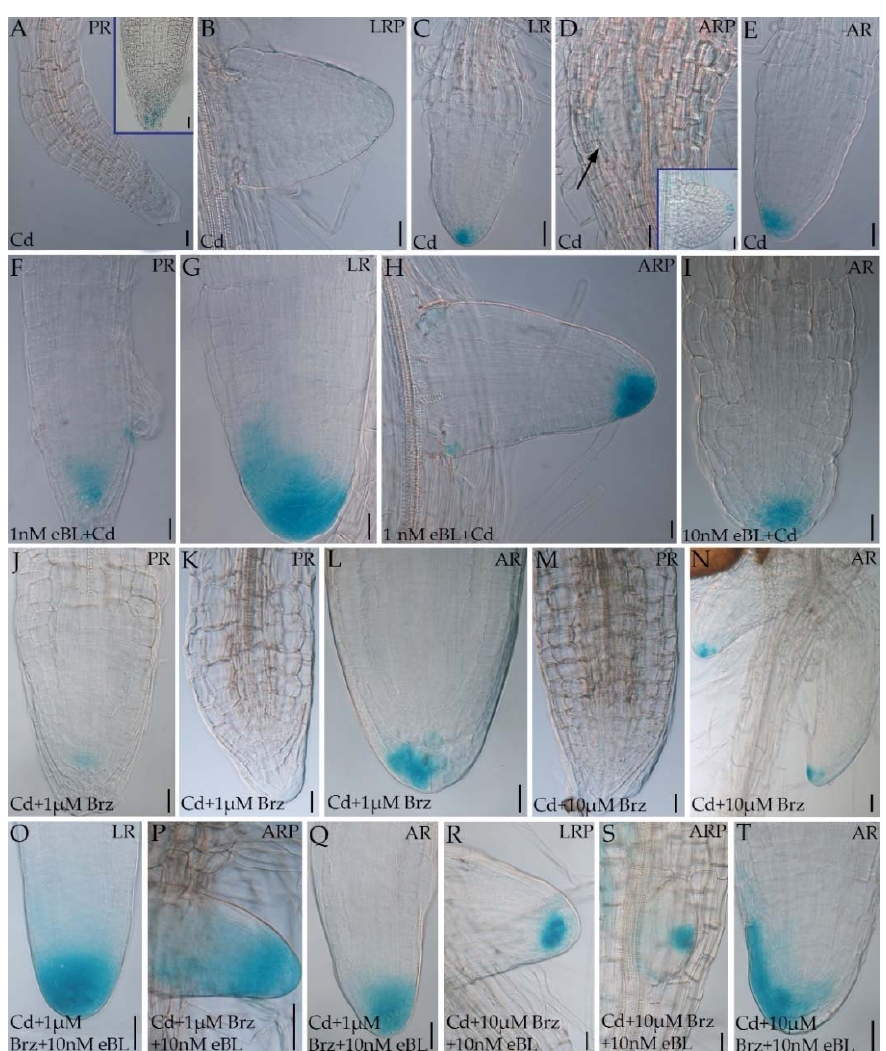
Figure 5. DR5::GUS expression in primary roots (PRs) ( A , and insert, F , J , K , M ), lateral roots (LR) primordia (LRP, B , R ), LRs ( C , G , O ), adventitious roots (AR) primordia (ARPs, D , arrow and insert, H , P , S ), and in AR apices ( E , I , L , N , Q , T ) of Col seedlings cultured for 9 days under continuous dark ‐ ness followed by 7 days under 16 h light/8 h darkness photoperiod on ½ MS medium (see Section 4) with either 60 μ M CdSO 4 (Cd, A – E ) or 1 nM eBL + Cd ( F , H ), or 10 nM eBL + Cd ( G , I ), or 1 μ M Brz + Cd ( J – L ), or 10 μ M Brz + Cd ( M – N ), or 1 μ M Brz + Cd +10 nM eBL ( O – Q ), or 10 μ M Brz + Cd +10 nM eBL ( R – T ). Bars = 20 μ m, inserts in A and D = 10 μ m. Images from the first replicate.